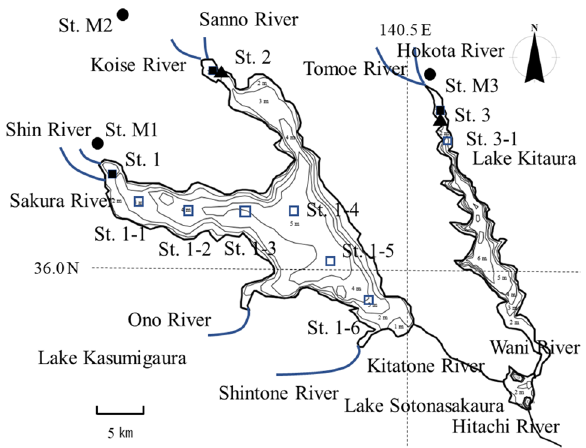
Fig. 1 Target water region (Lake Kasumigaura and Lake Kitaura) and monitoring points. Solid squares : Water sampling points close to influent river. Open squares: Water sampling points in offshore areas. Solid triangles: Stations for continuous water-quality monitor- ing. Solid circles: Stations for meteorological